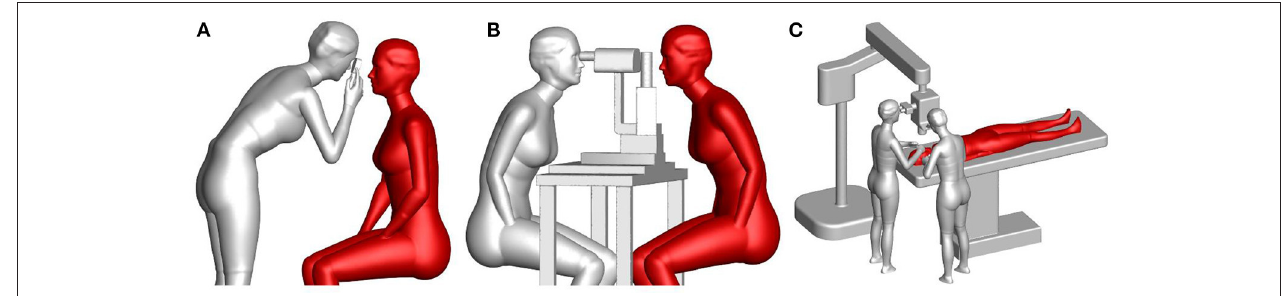
FIGURE 1 | Numerical models of typical ophthalmic procedures: (A) a direct ophthalmoscopic examination, (B) a slit-lamp microscopic examination, and (C) an ophthalmic operation (gray manikin = ophthalmologist, red manikin = patient).